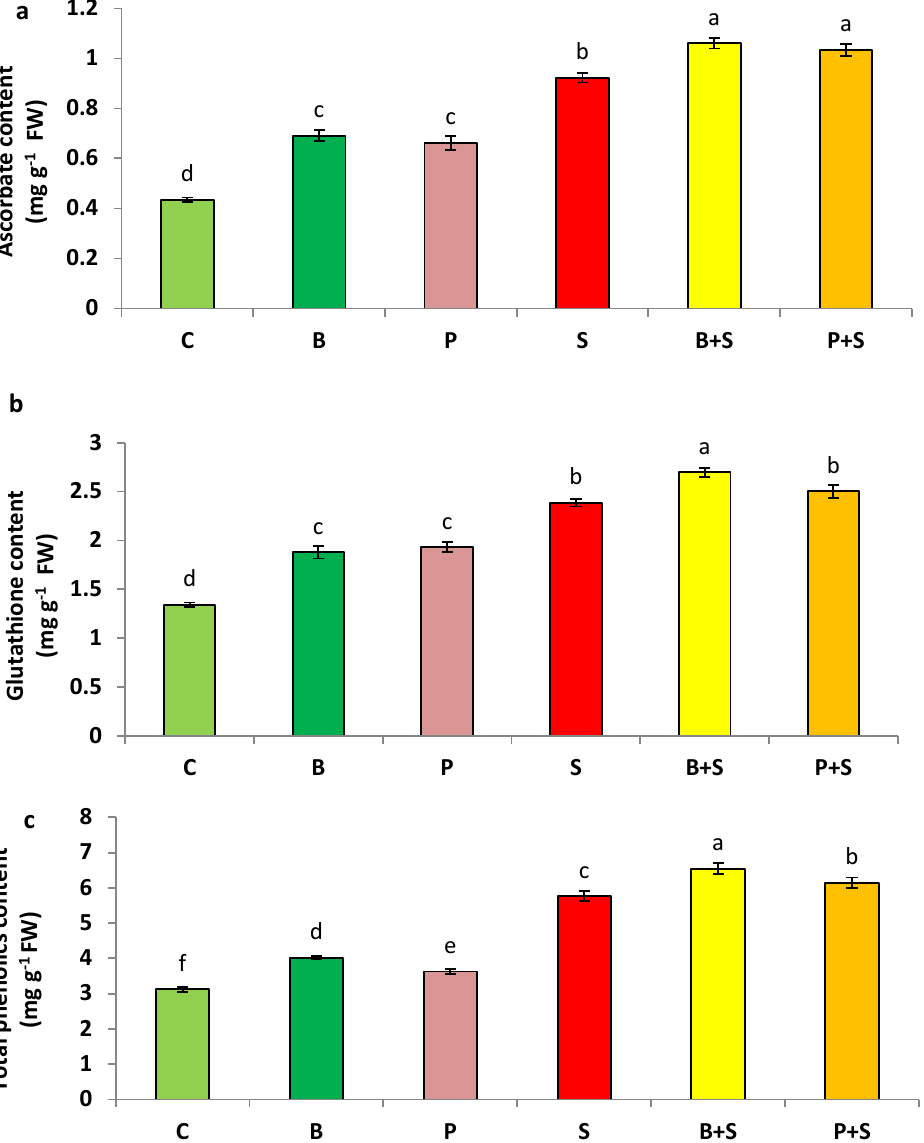
Figure 3. Effect of BABA and PEG seed priming on ascorbate ( a ), glutathione content ( b ), and total phenolics content ( c ) in cowpea seedlings exposed to PEG stress. C (control), B (BABA-primed seedlings without any stress), P (PEG-primed seedlings without any stress), S (unprimed seedlings subjected to PEG stress), B + S (BABA-primed seedlings subjected to PEG stress), P + S (PEG-primed seedlings subjected to PEG stress). Values represent the mean ± SE of three independent experiments. Alphabetical letters show significant difference between treatments performed using Duncan’s multiple range